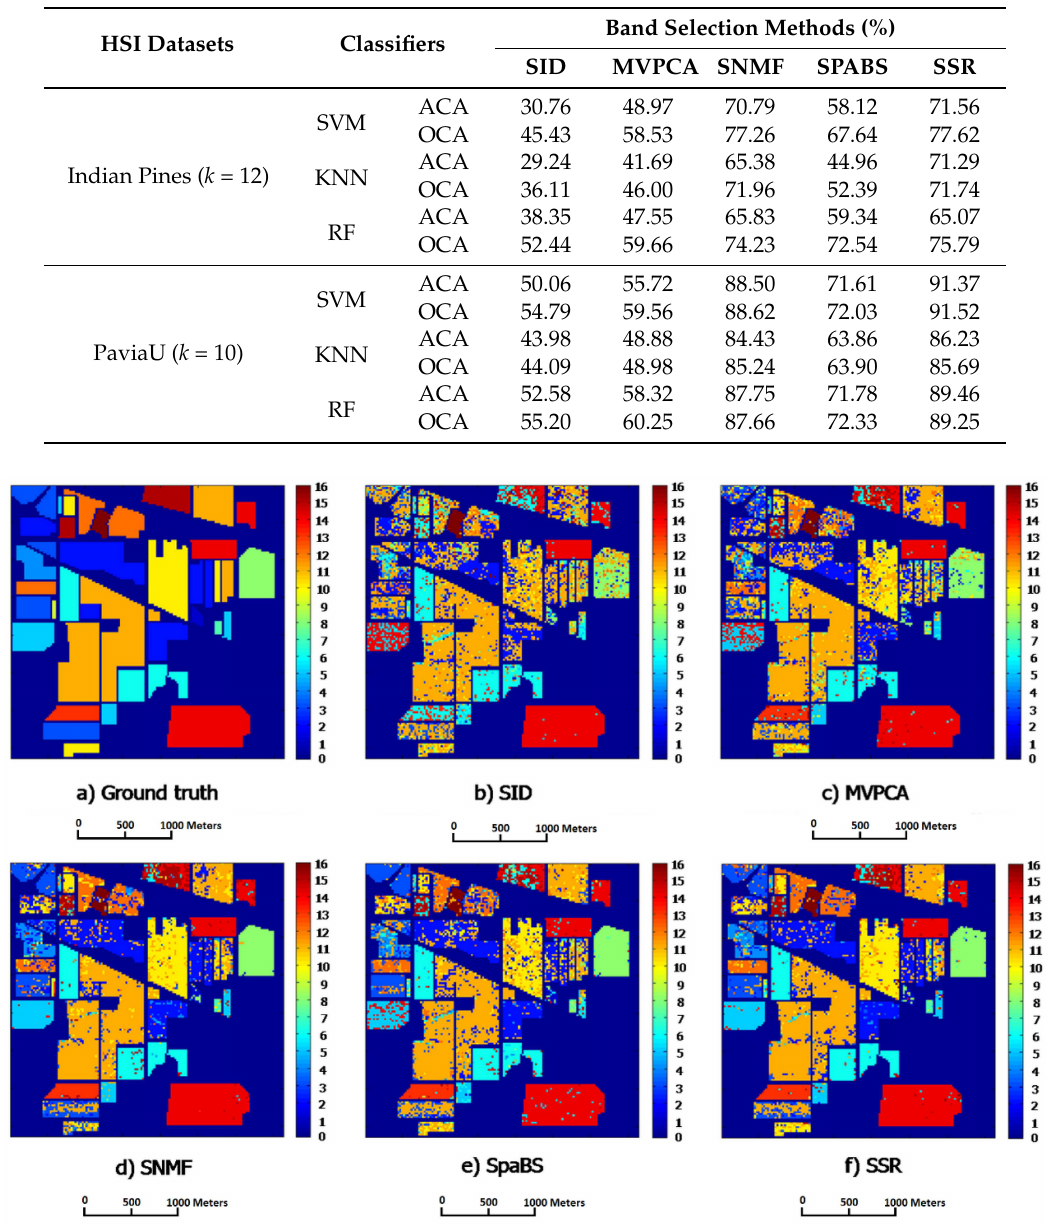
Figure 4. Classification maps of all five methods on Indian Pines dataset using the SVM classifier. ( a ) Ground truth; ( b ) SID; ( c ) MVPCA; ( d ) SNMF; ( e ) SpaBS; and ( f )